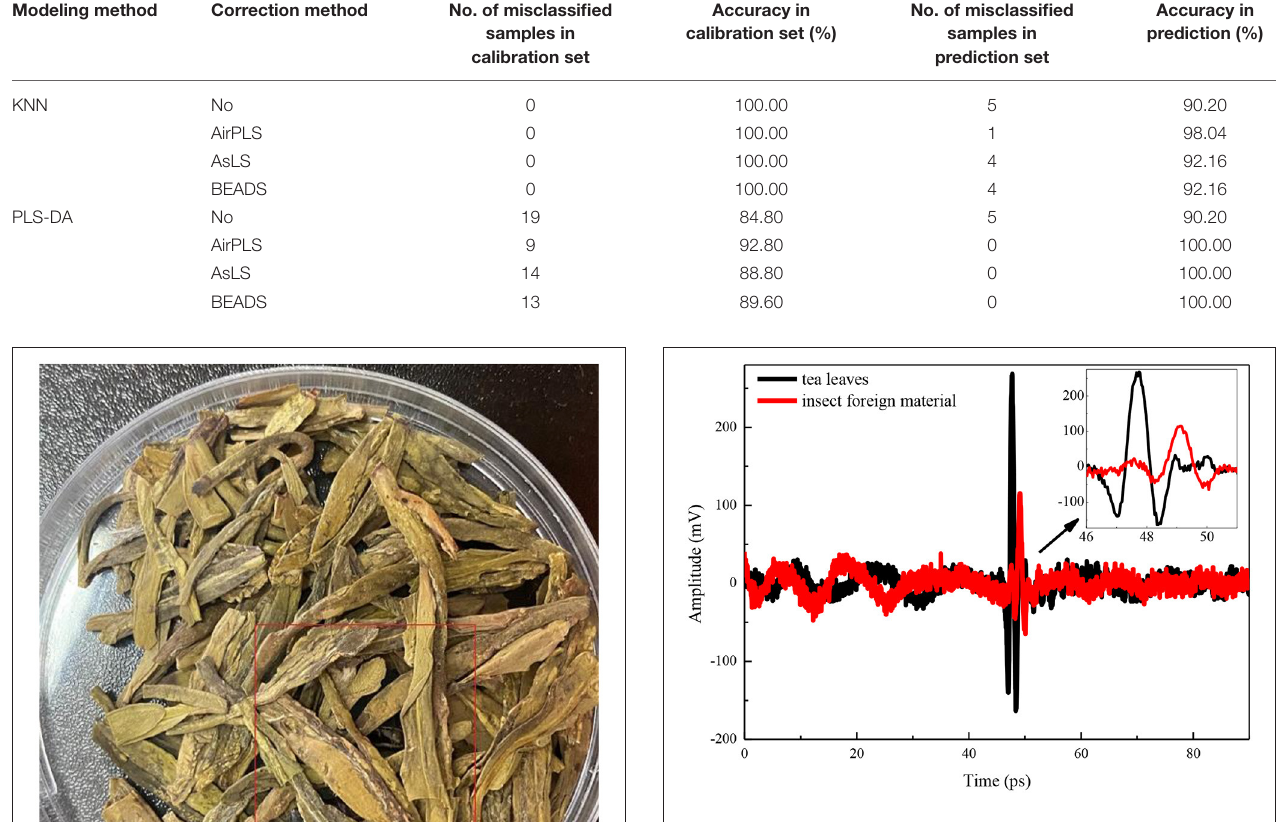
FIGURE 6 | Time domain waveforms for the region of interest of tea leaves and insect foreign